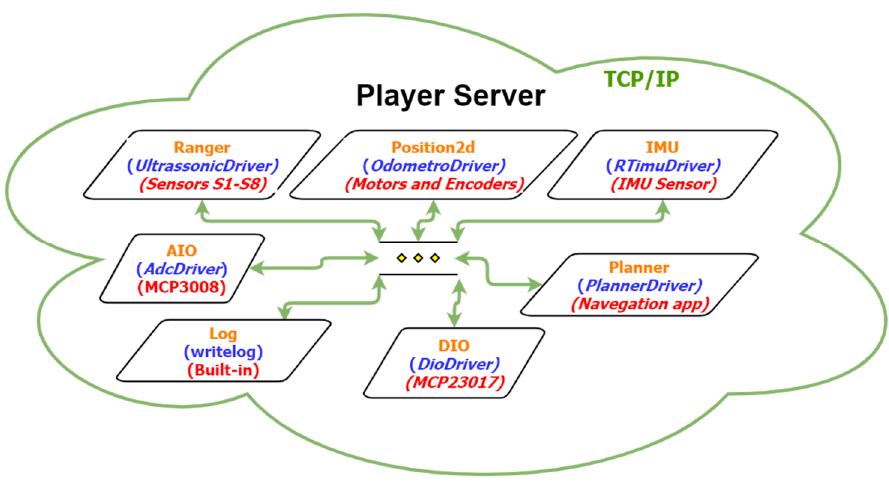
Figure 6. Macro diagram of Player server drivers.